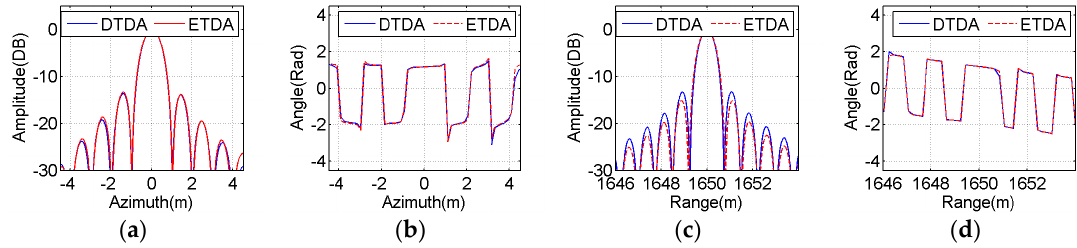
Figure 12. Comparison between the focused results obtained by the bistatic DTDA and proposed ETDA for the point-like scatterer E. ( a ) Azimuth amplitude; ( b ) Azimuth phase; ( c ) Range amplitude; ( d ) Range phase.